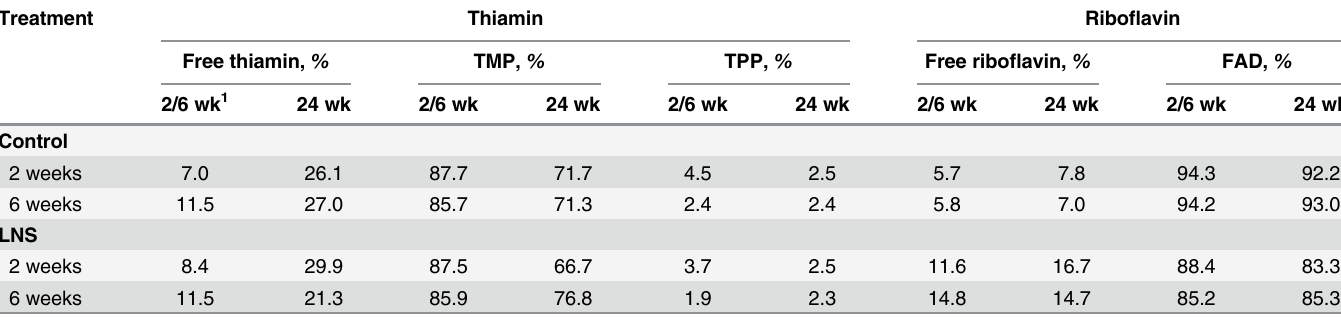
Table 3. Median relative contribution [%] to total thiamin and total riboflavin from each vitamer analyzed in milk from HIV-infected Malawian women, and change over time.